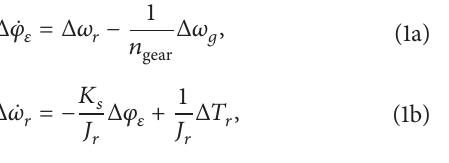
turbine and the interactions between the different dynamic components in the model. The whole wind turbine can be divided into four subsystems: aerodynamics subsystem, mechanical subsystem, electrical, and actuator subsystem